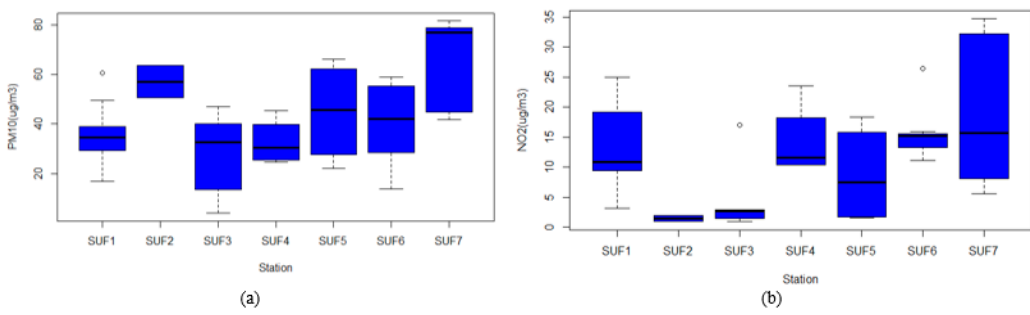
Figure 3. Box plots of ( a ) PM 10 concentrations ( b ) NO 2 concentrations of the 7 monitoring stations.